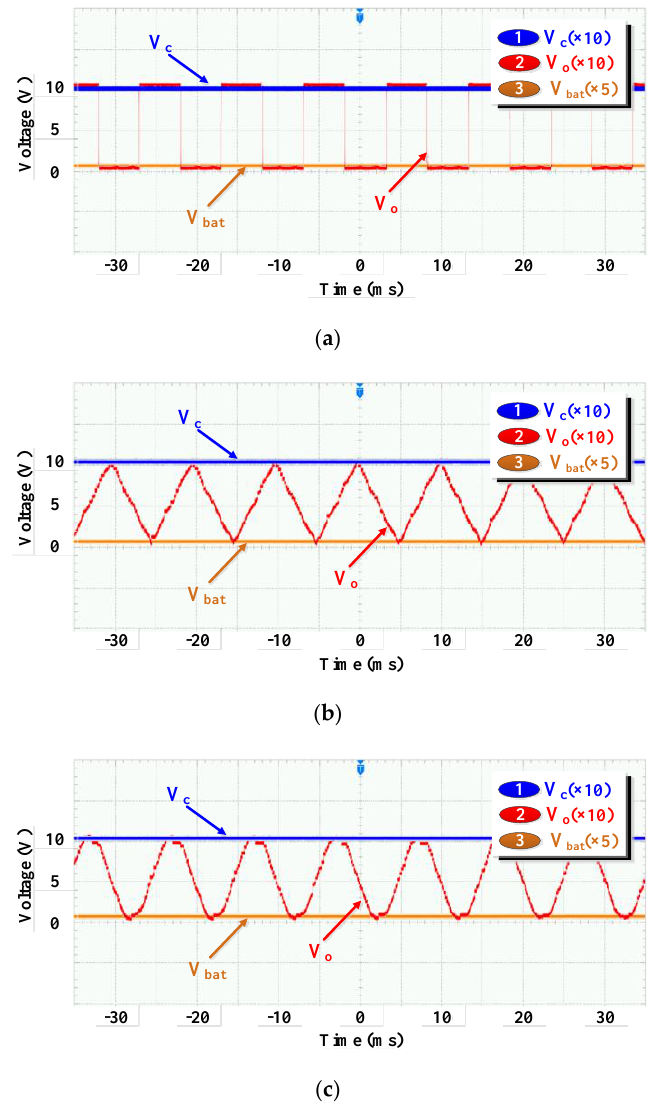
Figure 13. Output voltages of each node (i.e., V bat , V c and V o ) in ( a ) square driving; ( b ) triangle driving; and ( c ) sinusoidal driving modes.